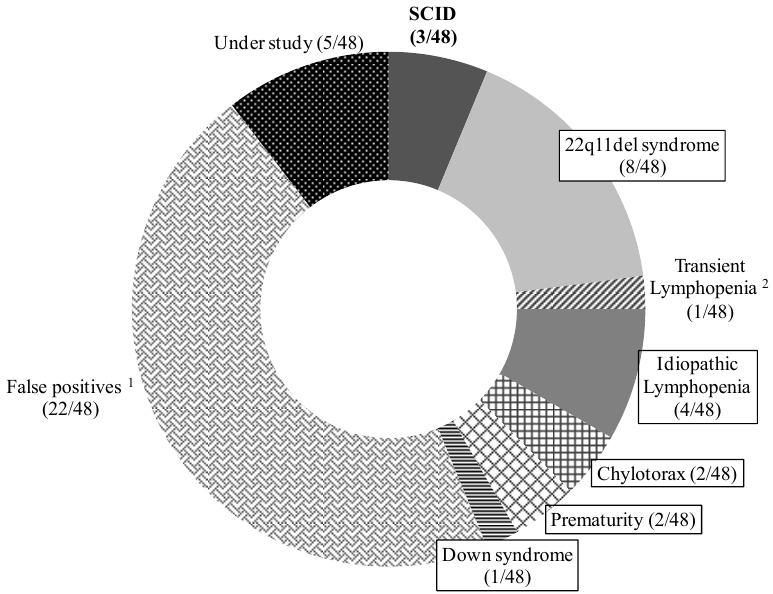
Figure 4. Final diagnoses in patients testing positive in Catalonia (January 2017–June 2020). 1 False- positives due to initially normal lymphocyte count with normalization of TRECs between three and six months of life; 2 Transient lymphopenia due to initially low lymphocyte count with recovery in the following months. Note: Final diagnoses of the 17 non-SCID lymphopenic patients are boxed. Abbreviations: SCID, severe combined immunodeficiency.